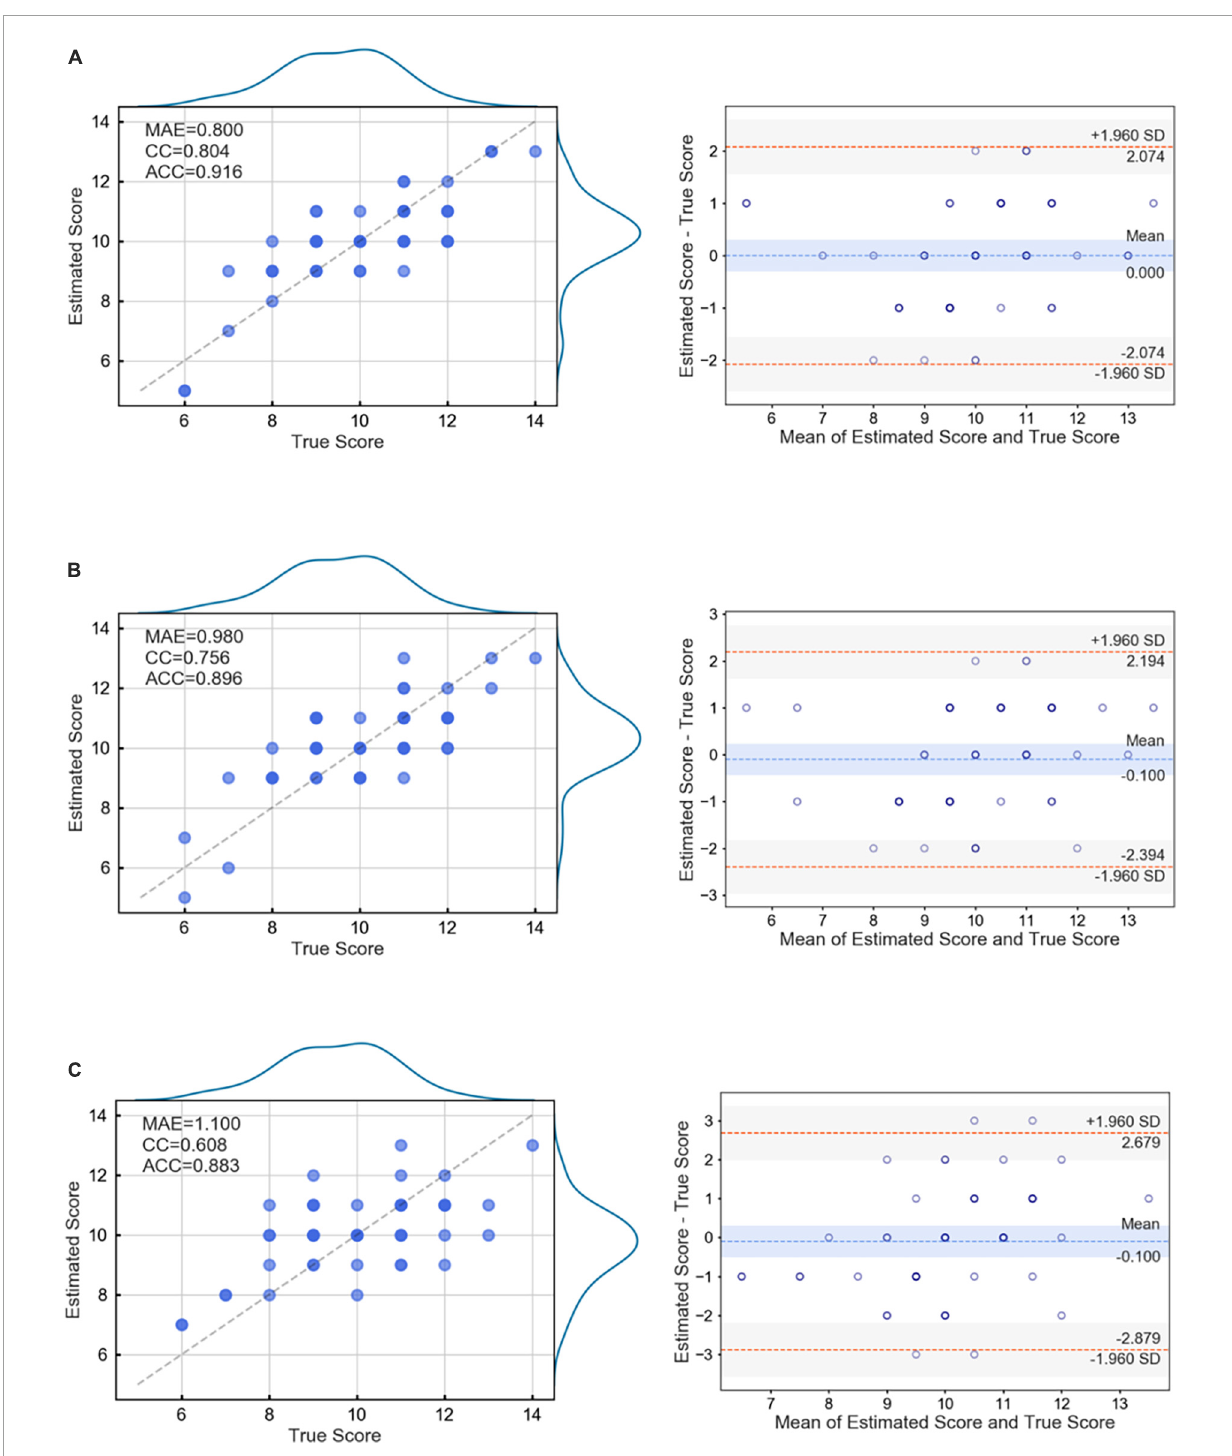
FIGURE6 Fitting result and Bland–Altman plot of the three regression models. (A) LASSO, (B) SVR, (C)